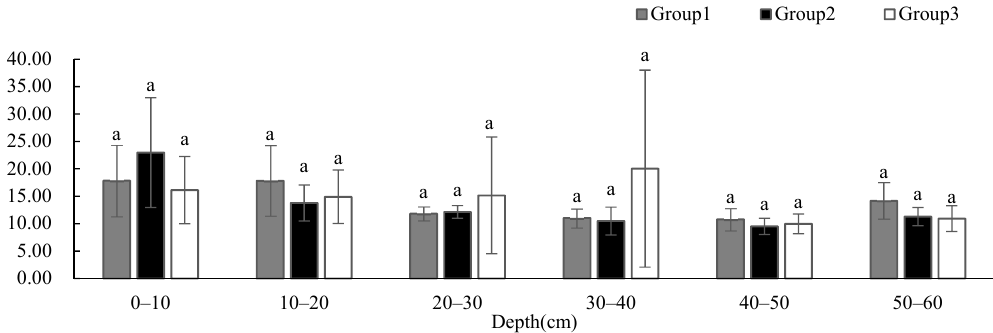
Figure 10. One-way ANOVA results of soil C/N under different vegetation cover types at different depths ( p < 0.05).